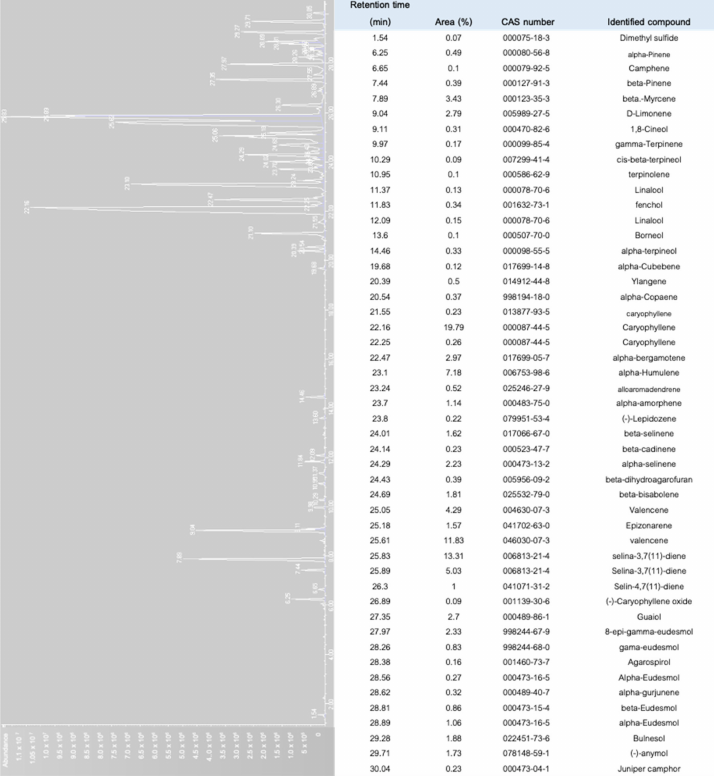
Figure 7. The chromatogram of the volatile profiles of Cannabis sativar L. var. Northern Light (https: // www.seedstockers.com). Denotes terpenes isolated from dried florescence (50 mg) using headspace solid phase microextraction (SPME) with 50 / 30 µ m carbowax-divinylbenzene, CAR-PDMS-DVB StableFlex fiber (Supelco, Bellefonte, PA, USA) followed by gas chromatography coupled with mass spectrometry